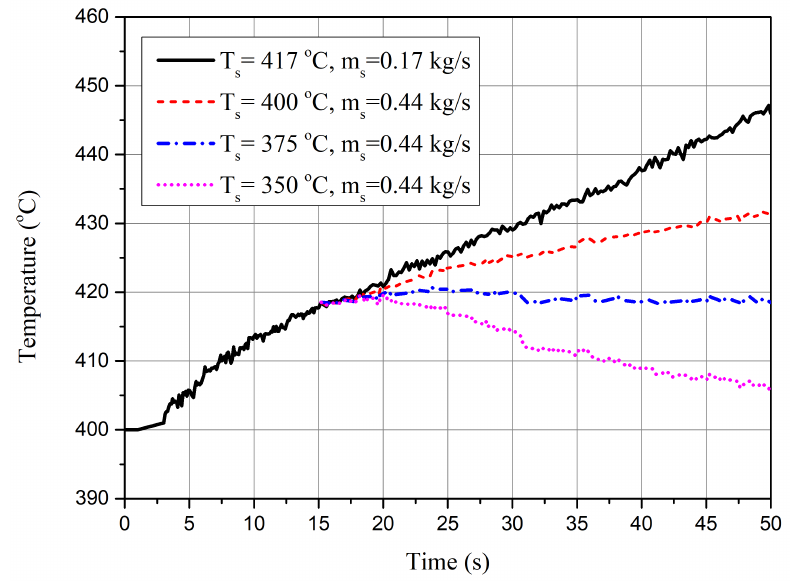
Figure 17. Profile of time evolution of temperature under different cooling effect of internal bubbling fluidized bed